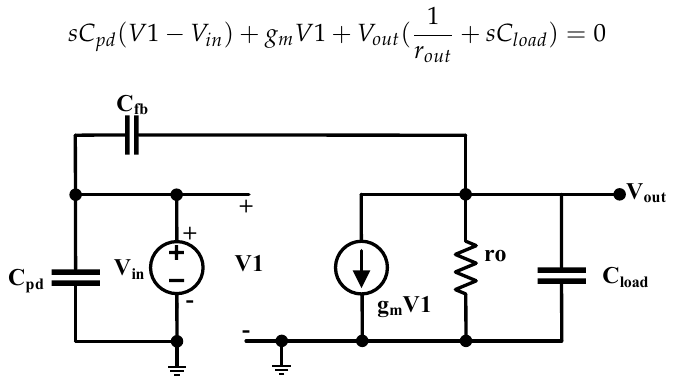
Figure 5. CTIA small-signal model- PMOS input